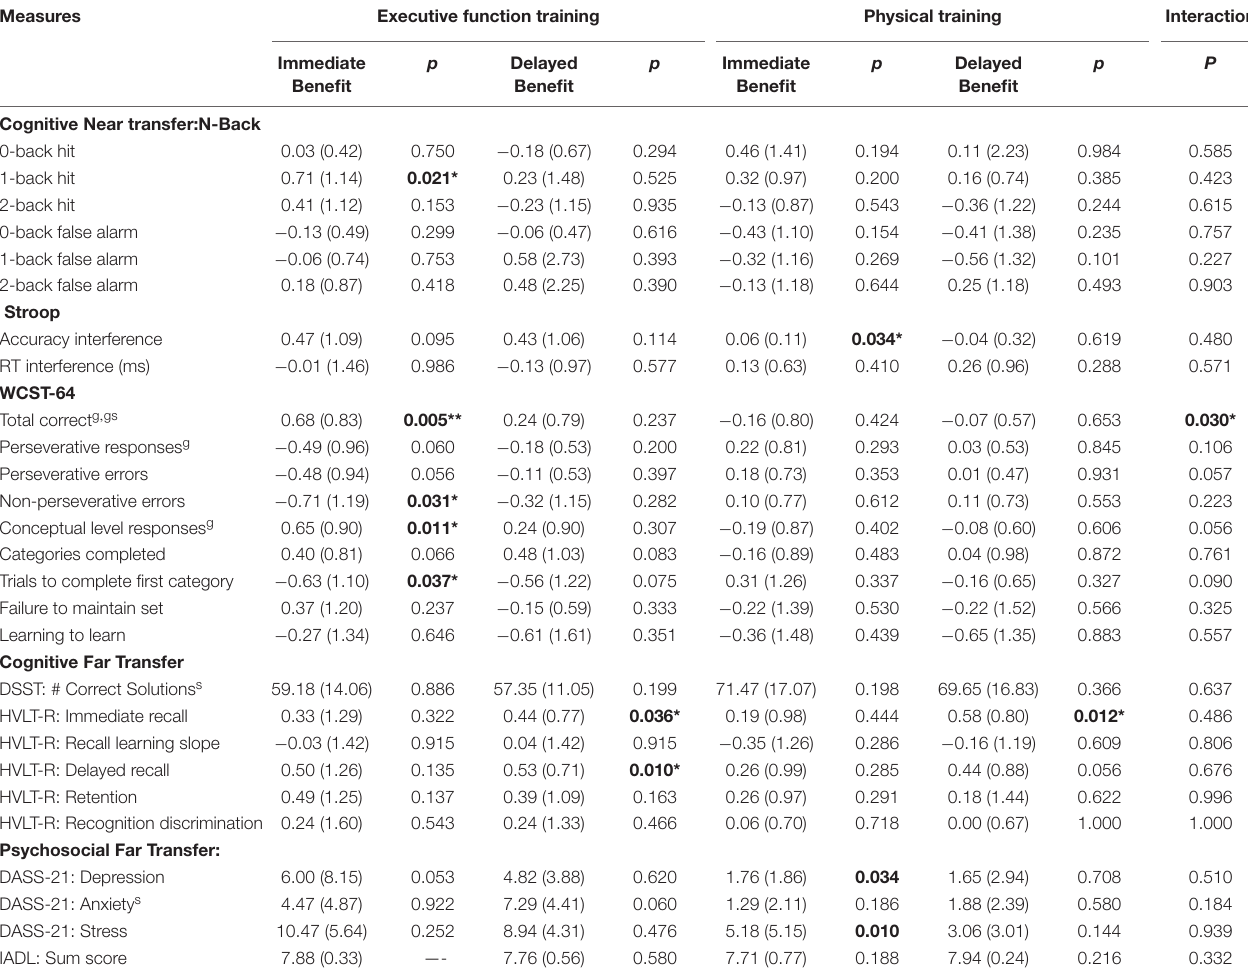
TABLE 3 | Immediate and delayed benefit effect size in the unit of baseline SD ( N =